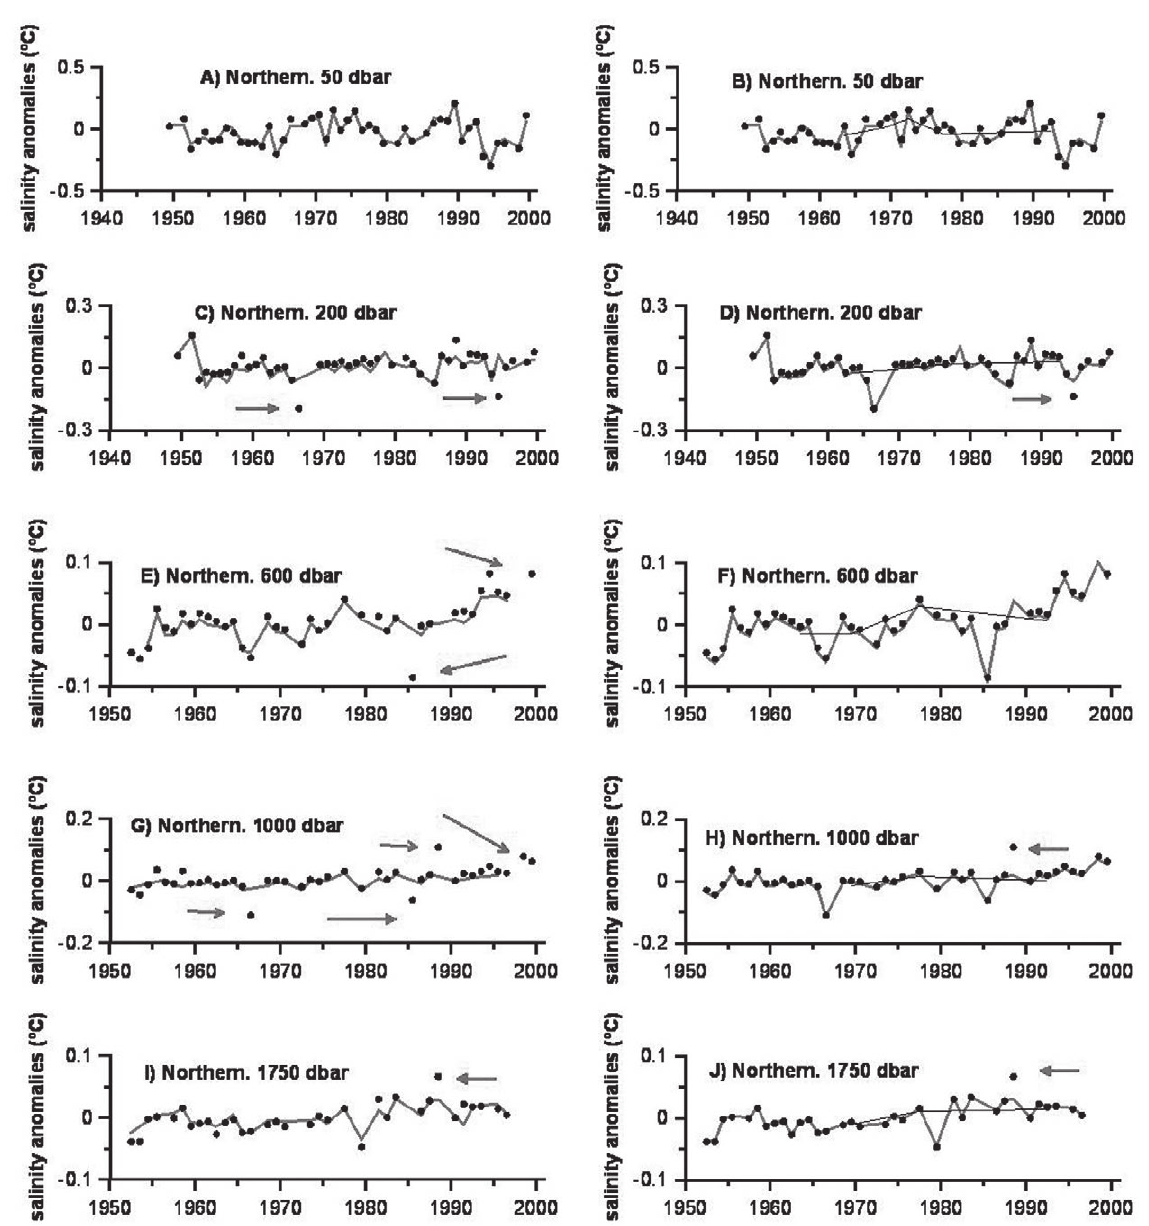
Fig . 5. – The same as in Figure 4, for the salinity in the northern